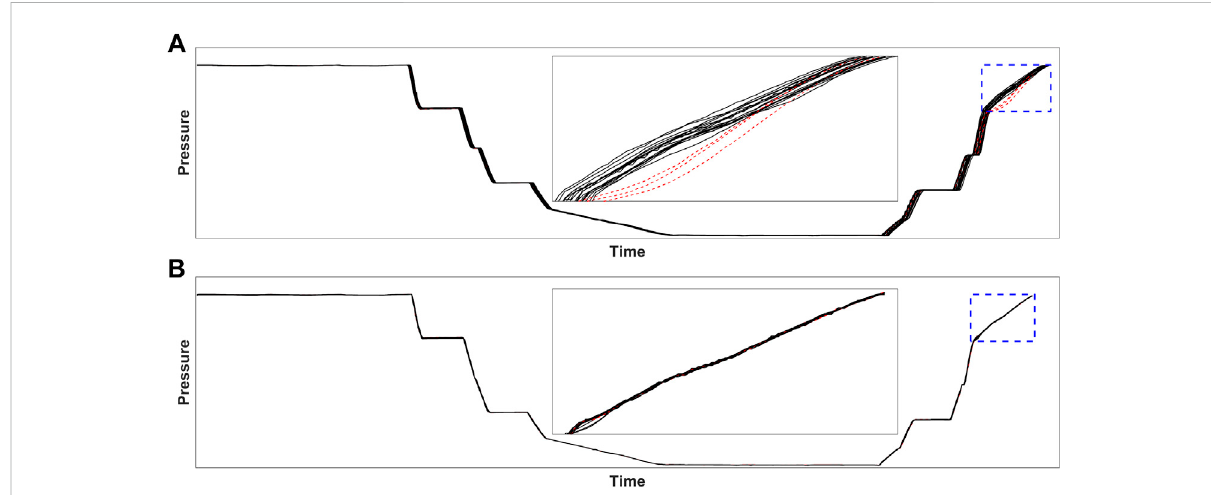
FIGURE 8 Comparison between the pressure pro fi les of (A) the original 16 test cycles and (B) the test cycles after DTW. The normal testing cycles are plotted in black solid lines while the faulty testing cycles are plotted in red dashed lined. The irregular discrepancies among cycles shown in the original pro fi les (highlighted in the blue dashed-line rectangles and the zoom-in views) have diminished after DTW, indicating that DTW causes signi fi cant information loss or